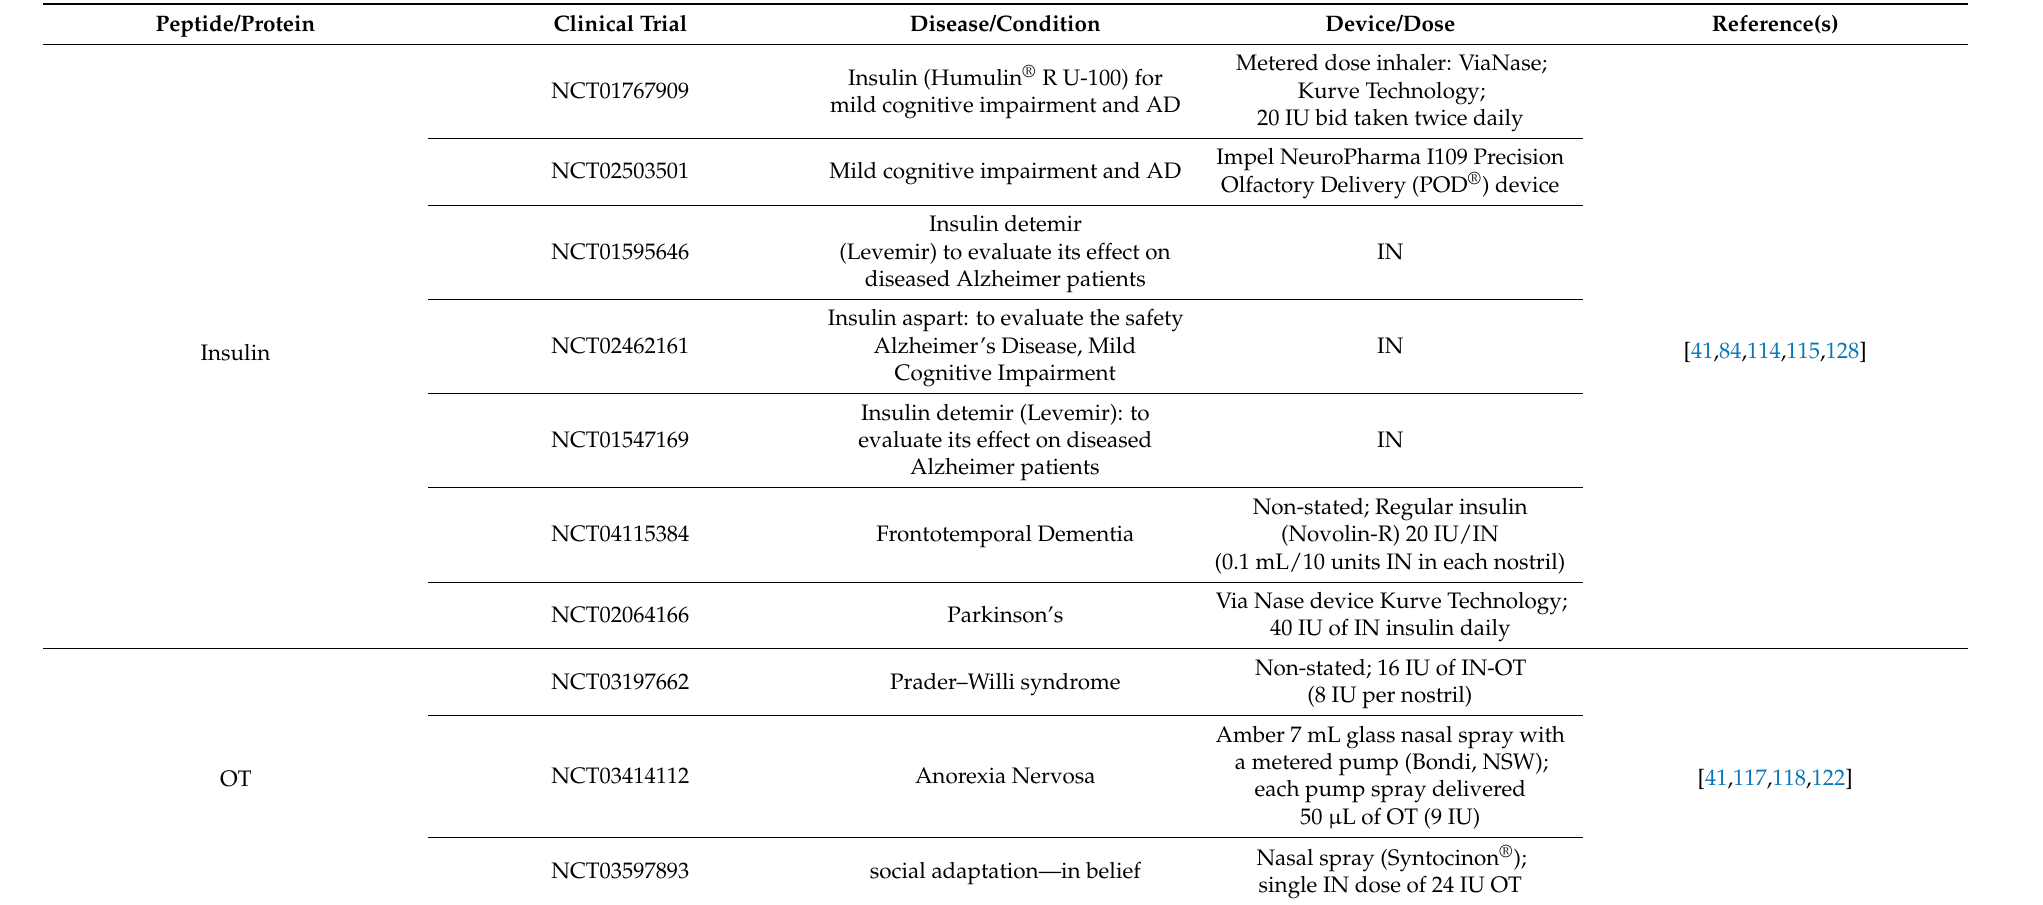
Table 4. Peptide/Proteins drugs in clinical trials for N-to-B